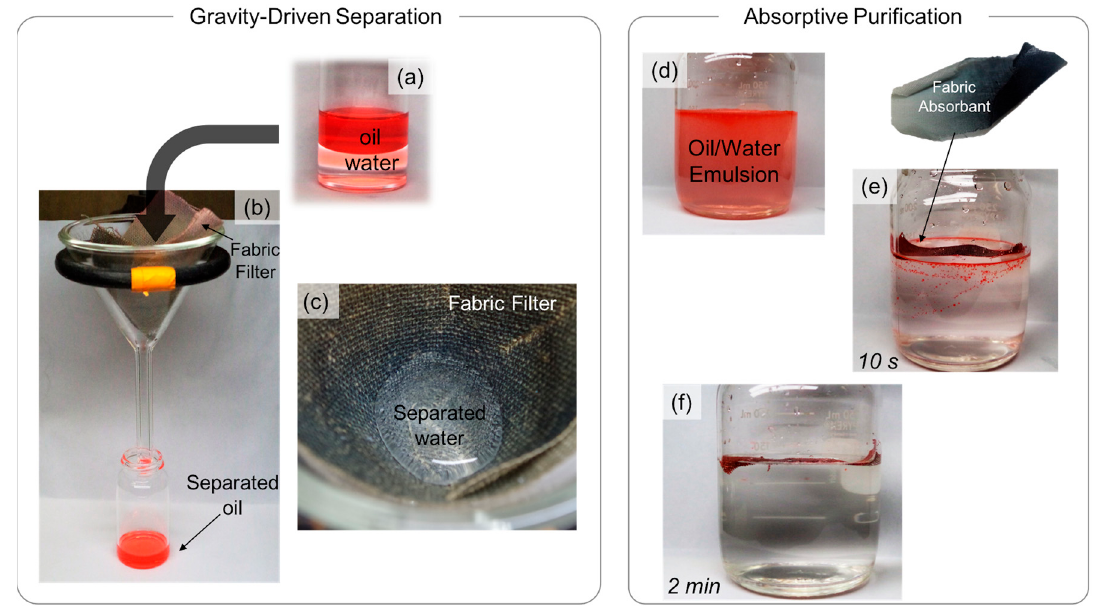
Figure 5. Gravity-driven separation of a two-phase oil/water mixture ( a ) using an F-PHMEDOT coated tight woven cotton fabric as a pass-through filter ( b ). The water phase remains in the fabric filter ( c ) while the oil phase is filtered through and collected ( b ). Removal of oil from a surfactant-stabilized oil/water emulsion ( d ) by immersing an F-PHMEDOT coated loose woven cotton fabric into the emulsion. The fabric absorbant selectively soaks up the oil particles after a short time ( e ) and oil is completely sequestered in the fabric after 2 min ( f ).